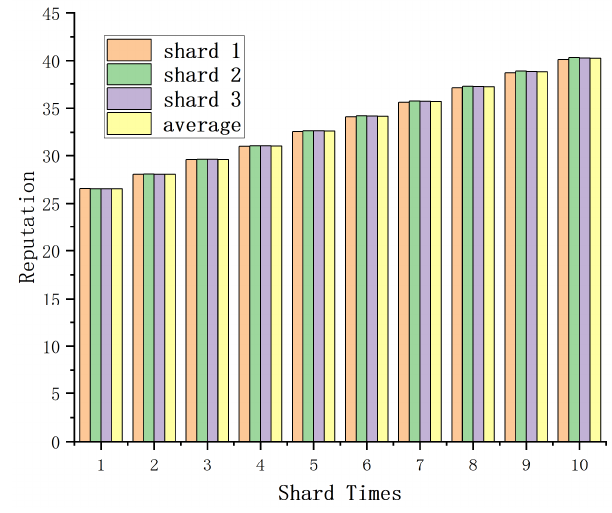
Figure 7. Comparison of reputation of different shards.